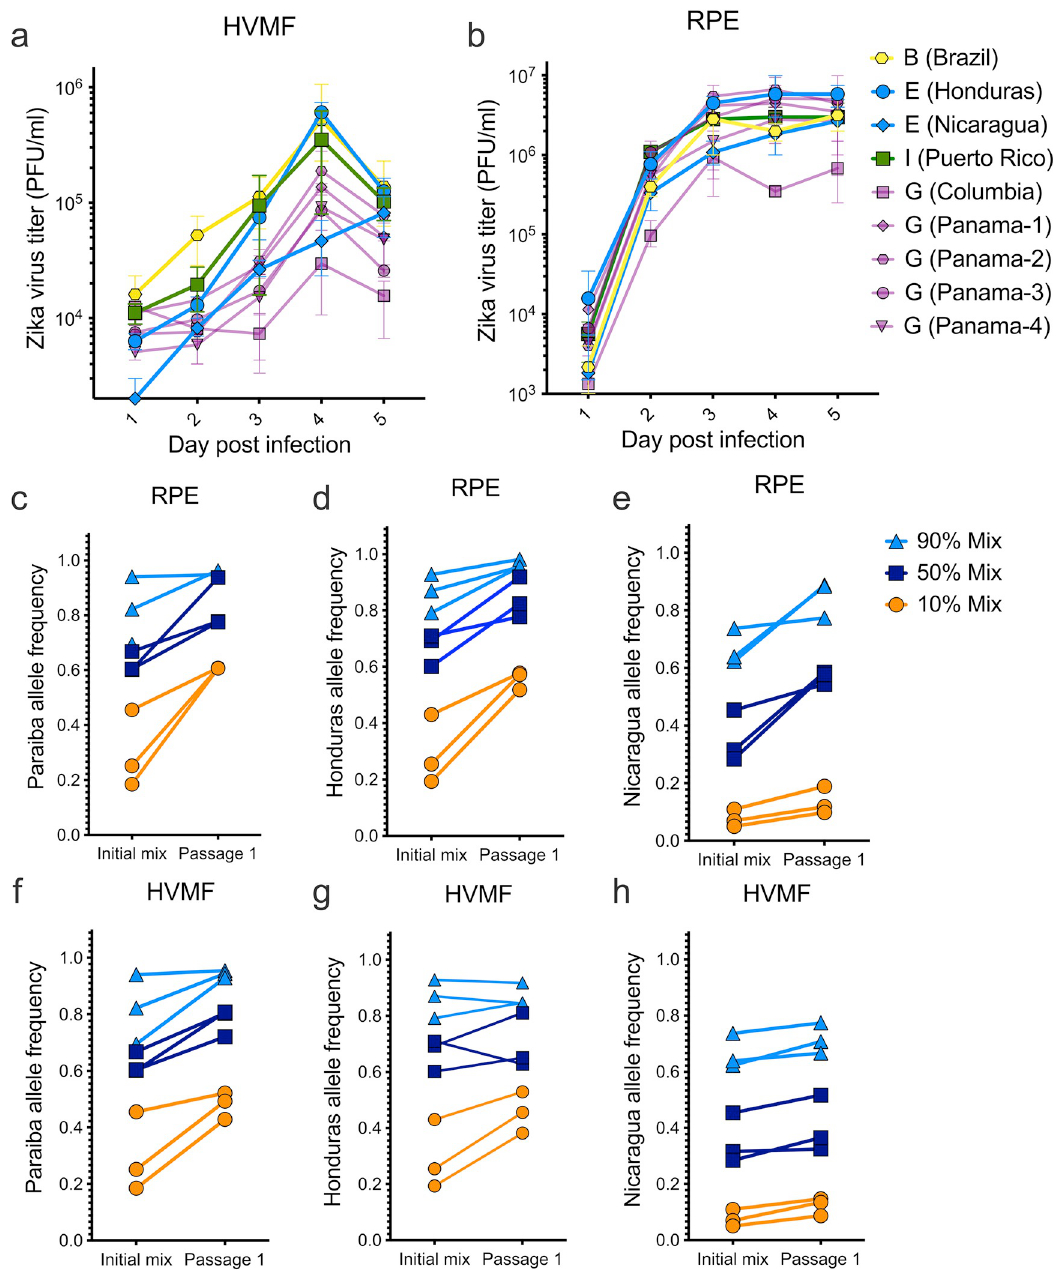
Fig 3. Replicative and competitive fitness results of Zika virus isolates in human primary cells: Infections of ( a ) HVMF and ( b ) RPE cells with nine Zika virus isolates representing clades B, E, G, and I. Growth curve points represent the average of the 5 biological replicates and error bars represent their range. Zika virus isolates from clades with high fitness (clades E and B) competed against a low fitness clade (clade G) using ( c-d ) RPE cells and ( f-h ) HVMF cells. Competitive fitness assays conducted at 90%, 50%, and 10% mixtures and each in triplicate, with three separate isolates representing clade G (PA259359, PA259634, and PAN259249). RPE, human retinal pigment epithelial cells; HVMF, human villous mesenchymal fibroblasts. correction, P = 0.001) as compared to clade A (Fig 4D). Furthermore, when running pairwise comparisons of dissemination rates between all clades, we found significantly higher dissemi- nation for clades PA3, B, and F (Fisher’s exact test with FDR correction, P = 0.008, 0.03, and